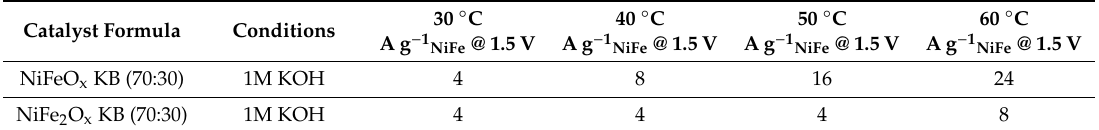
Table 2. In-situ mass activity for the NiFeO x / KB and NiFe 2 O x / KB catalysts with the Sustainion ™ membrane.